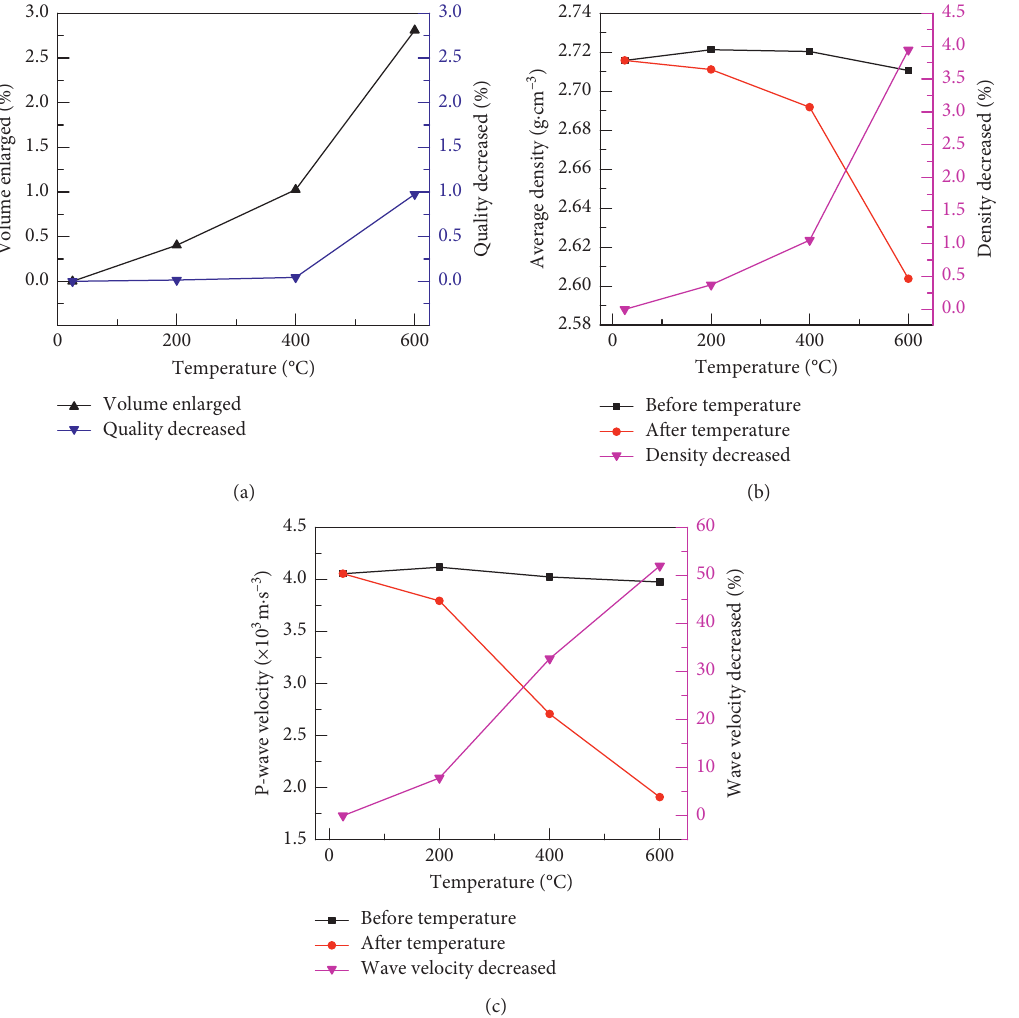
Figure 3: Relationship between basic physical parameters of limestone and temperature. (a) Volume and mass. (b) Density. (c) Longitudinal wave